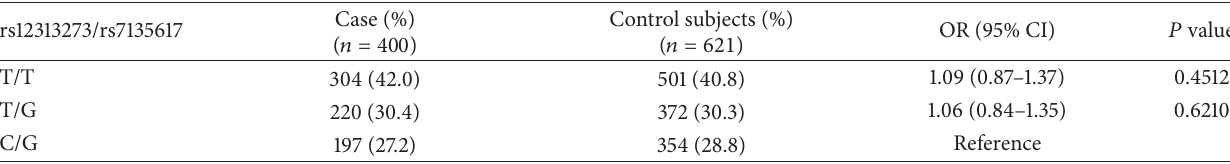
Table 3: Haplotype frequencies of the ORAI1 gene in rheumatoid arthritis patients and normal controls patients. rs12313273/rs7135617